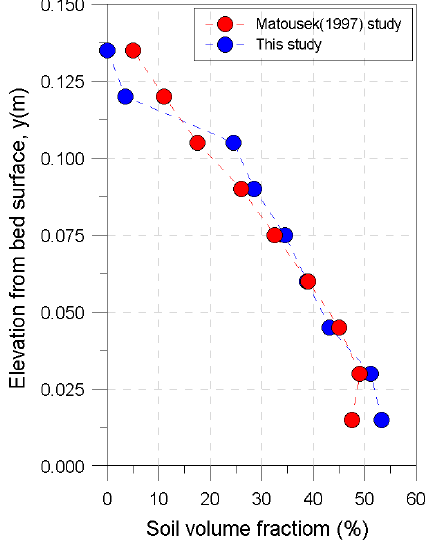
Figure 2. Comparison of modeling verification results (this study) with experimental data [50], for flow velocity of 3.5 m/s.